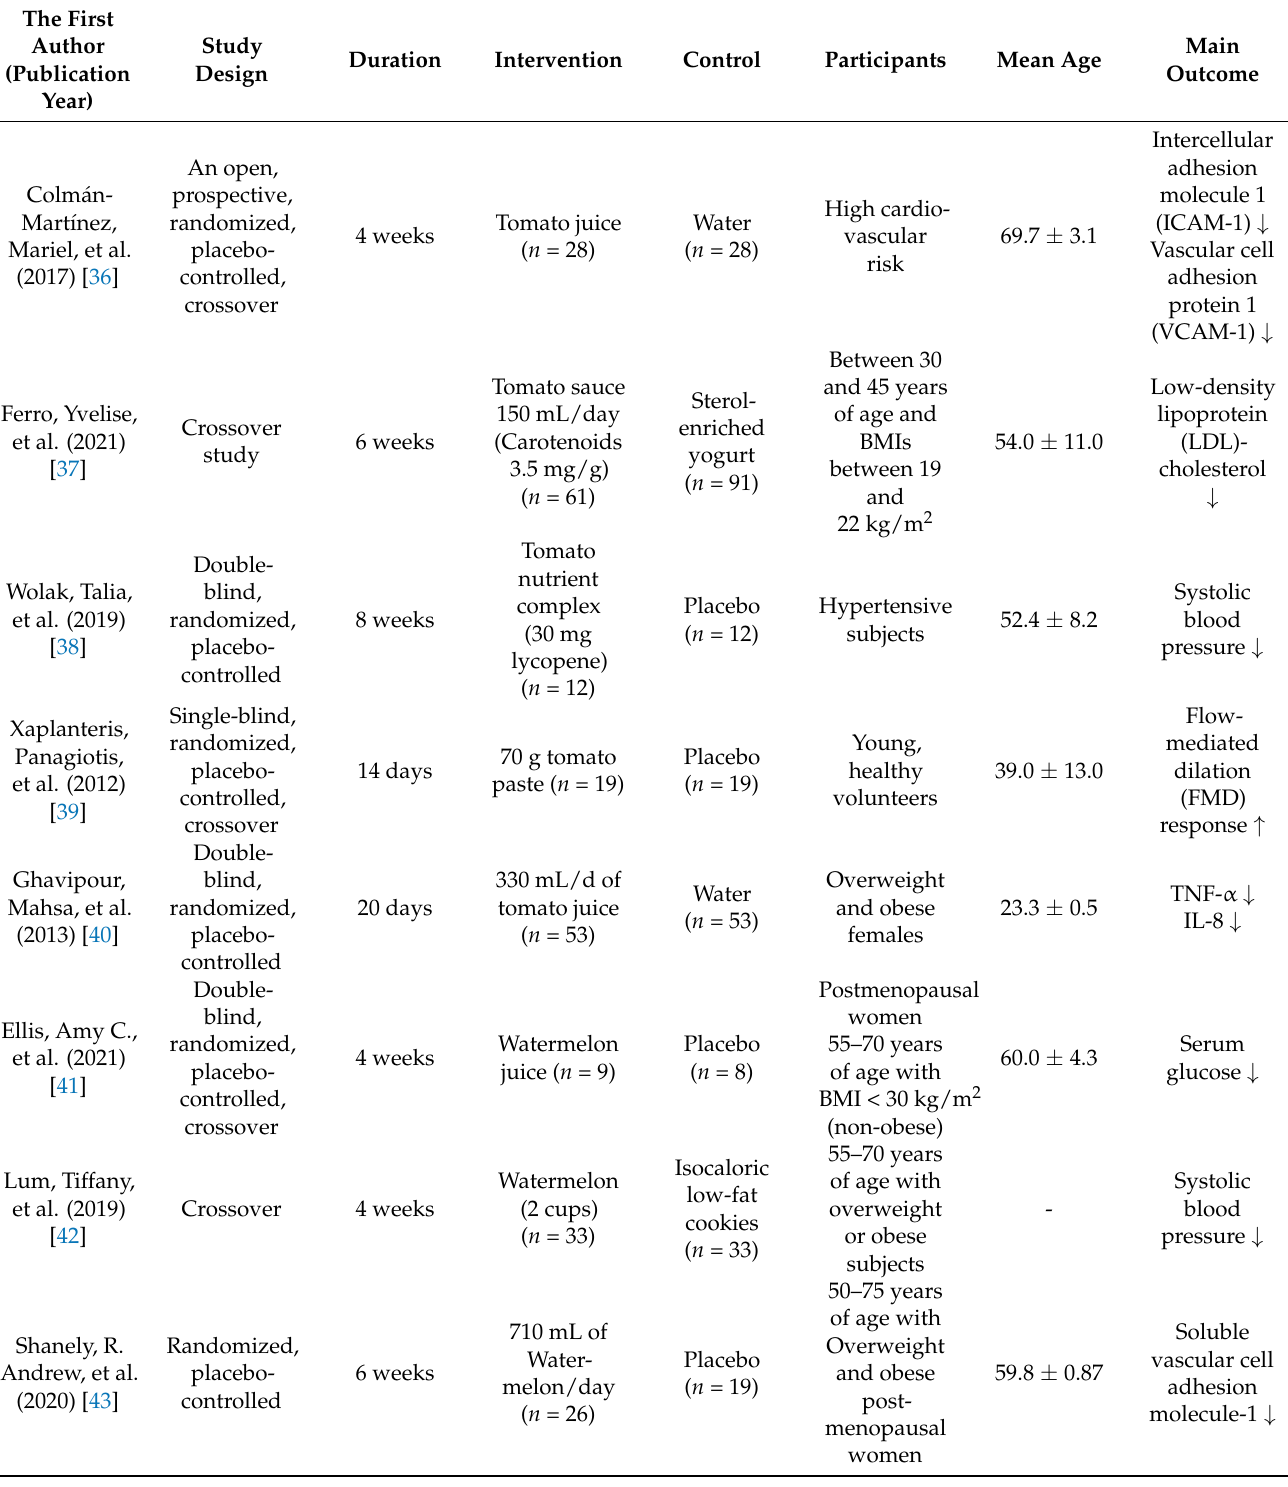
Table 4. Biological activities of red-colored food-derived